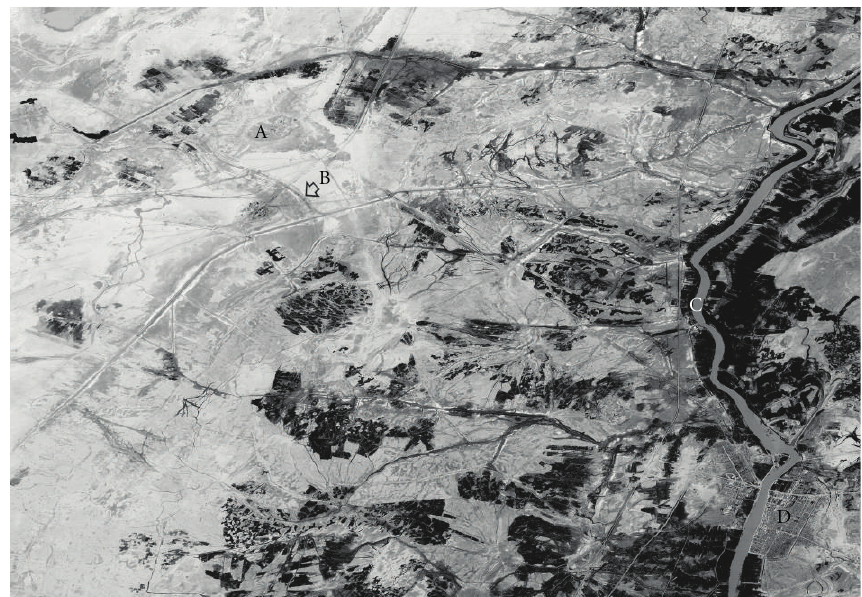
Figure 14: Gambit KH-7 oblique photo of 1966: A: Ur; B: paleo river bed of the Euphrates; C: present river bed of the Euphrates; D: Nasiriyah.